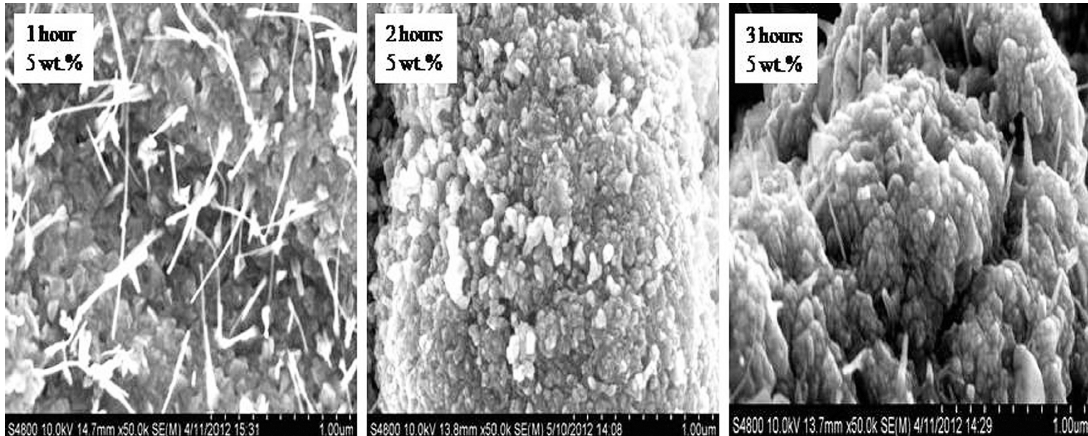
-5 wt.% O for 1. 2 and 3 hours. 2 2